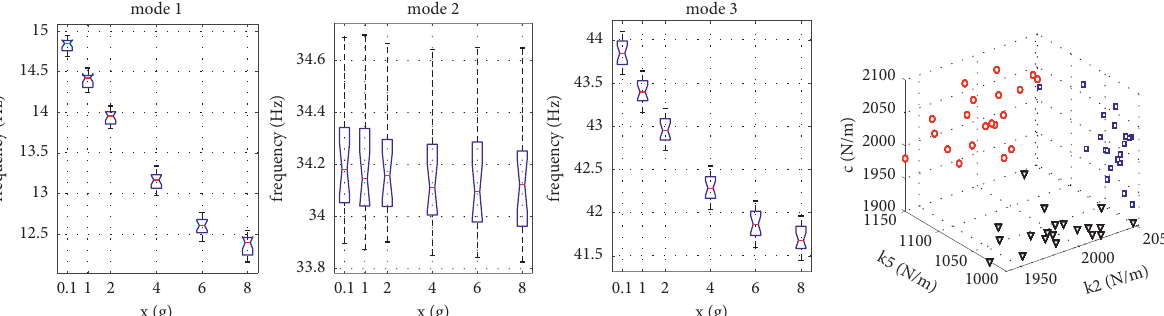
Figure 13: Boxplots of virtual frequency data for case study 3 and the projective plots of the corresponding 20 samples for aleatory uncertain